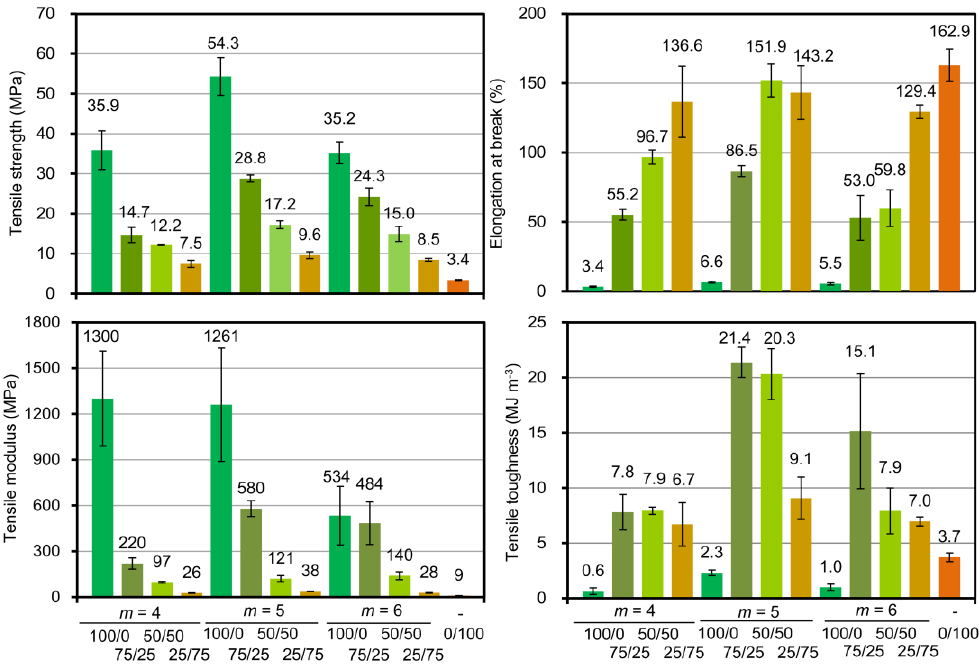
Figure 10. Tensile properties of SPN- m scLAO/3CLOs (100/0, 75/25, 50/50, 25/75 and 0/100, m = 4, 5 and 6).